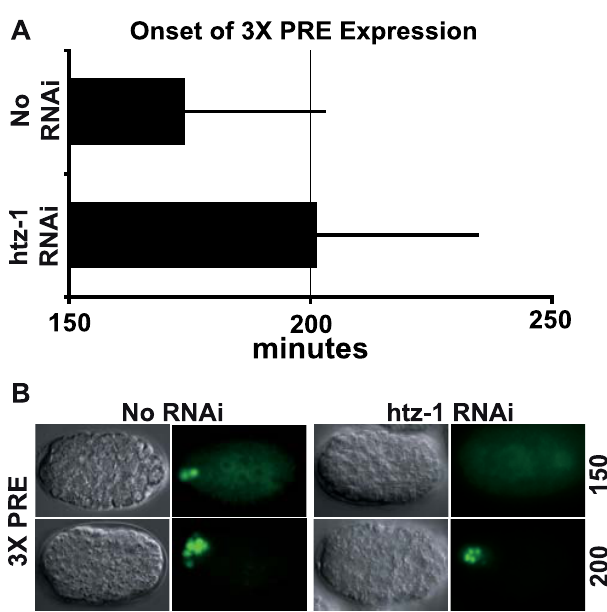
Figure 8. htz-1 Influences the Onset of Early PHA-4–Dependent Expression (A) Onset of 3XPRE::GFP after the two-cell stage for wild-type (black) or htz-1(RNAi) (grey) embryos . 3XPRE::GFP is a reporter construct with three copies of a high-affinity PHA-4 response element upstream of the D pes- 10 promoter that reproducibly activates early pharyngeal expression [19]. Activation of the 3XPRE::GFP reporter is delayed after injection of htz-1 dsRNA ( p ¼ 0.0289, Student t -test). No RNAi: n ¼ 23, htz-1 RNAi: n ¼ 9 embryos. Error bars indicate the standard deviation. (B) Expression of 3XPRE::GFP at 150 and 200 min after the two-cell stage with htz-1 RNAi or without (No RNAi). DOI: